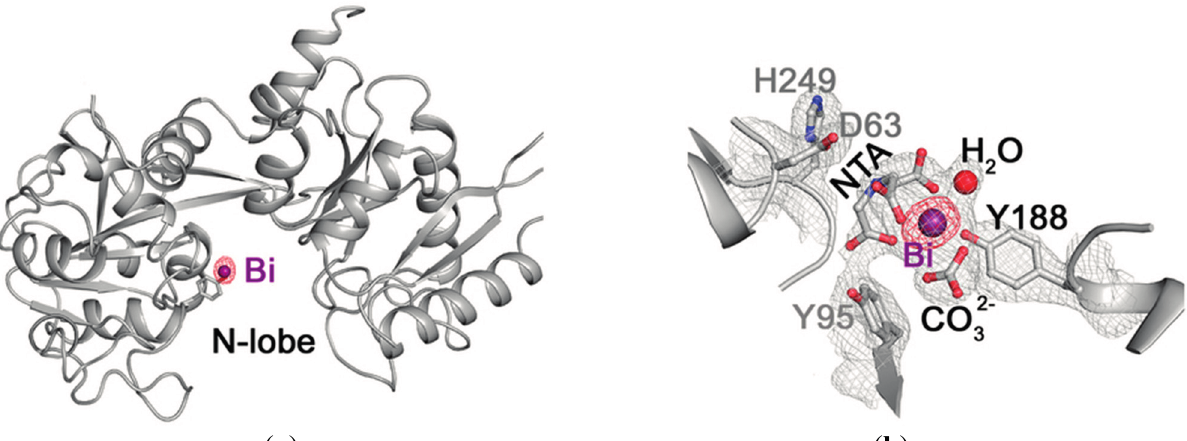
Figure 4. ( a ) Anomalous electron density of Bi N Fe C -hTF. The hTF backbone is shown in grey ribbon with the residue Tyr188 and Bi(III) represented as stick and sphere models respectively. The anomalous electron density map (contoured at 10 σ ), calculated from diffraction data collected at 0.92000 Å, is shown as red mesh and indicates the location of atoms that strongly absorb X-ray photons of this energy; ( b ) Coordination of Bi(III) in the N-lobe of Bi N Fe C -hTF. The gray 2 F obs − F calc map is contoured at 1.0 σ and the red anomalous electron map is contoured at 10.0 σ . The side chains of putative binding residues Asp63, Tyr95 and His249 are 6.7, 9.9 and 5.5 Å away from the Bi(III), respectively. Reproduced with permission from [42]. Copyright (2012) Nature Publishing